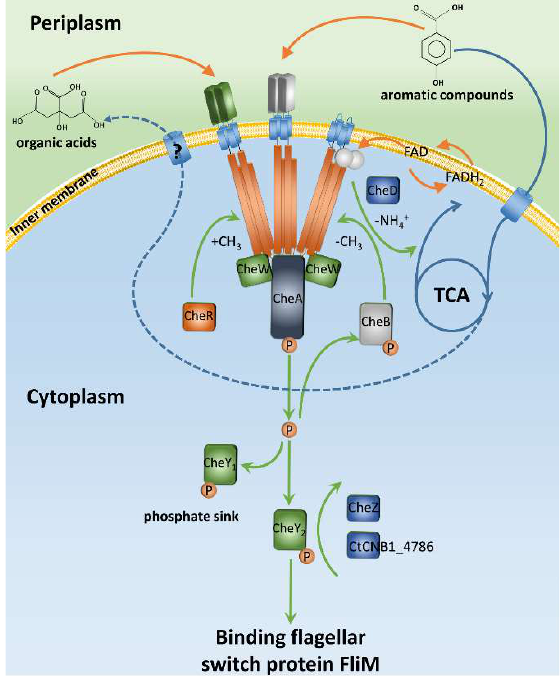
Figure 3. The Comamonas testosteroni CNB-1 chemotaxis pathway. Both metabolism-dependent and -independent chemotaxis exist in CNB-1 simultaneously. Some chemoreceptors directly sense aromatic compounds, and others sense metabolic intermediates or energy levels. The dotted line indicates a postulate pathway of material transportation.